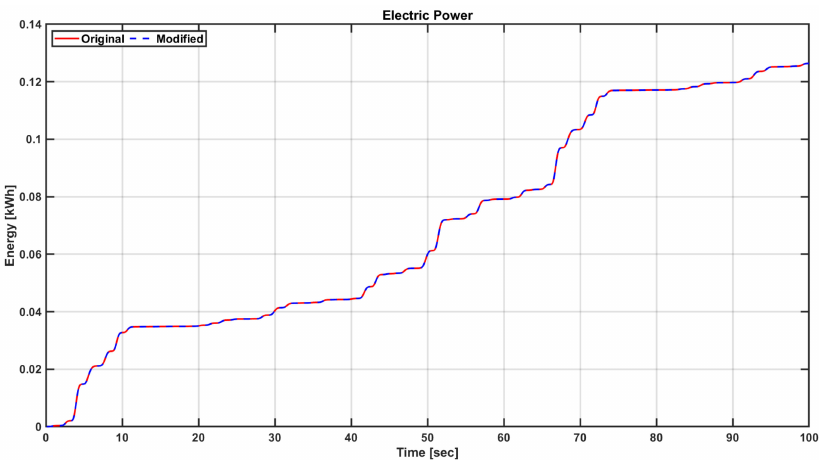
Figure 32. Power generation performance comparison results according to flow coe ffi cient range change under irregular wave ( v t = 0~42 m / s and Tp = 4.75 s) input